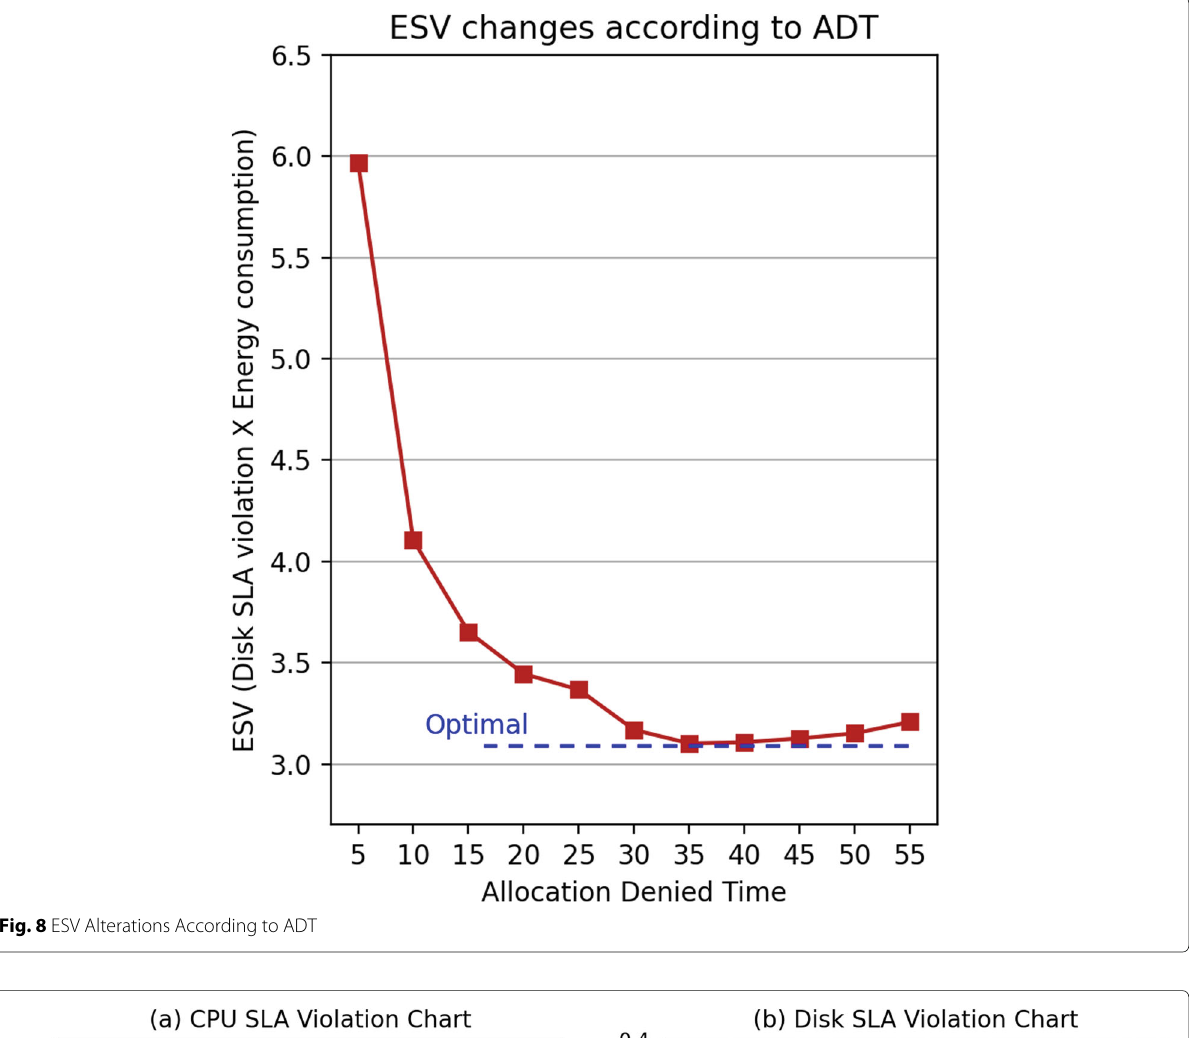
Fig. 8 ESV Alterations According to ADT